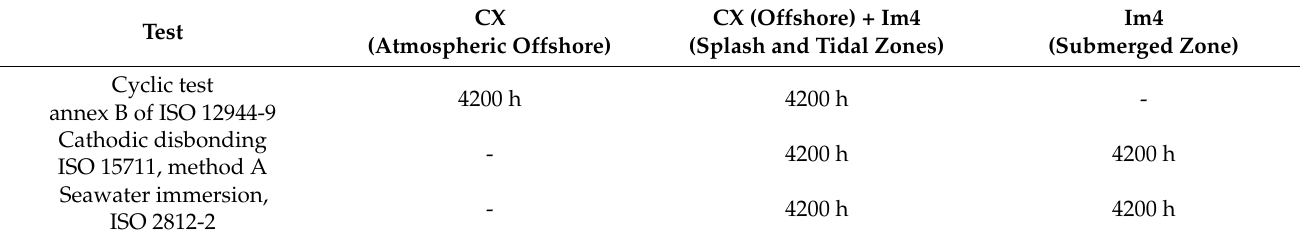
Table 2. Qualification tests for offshore coatings for different corrosivity